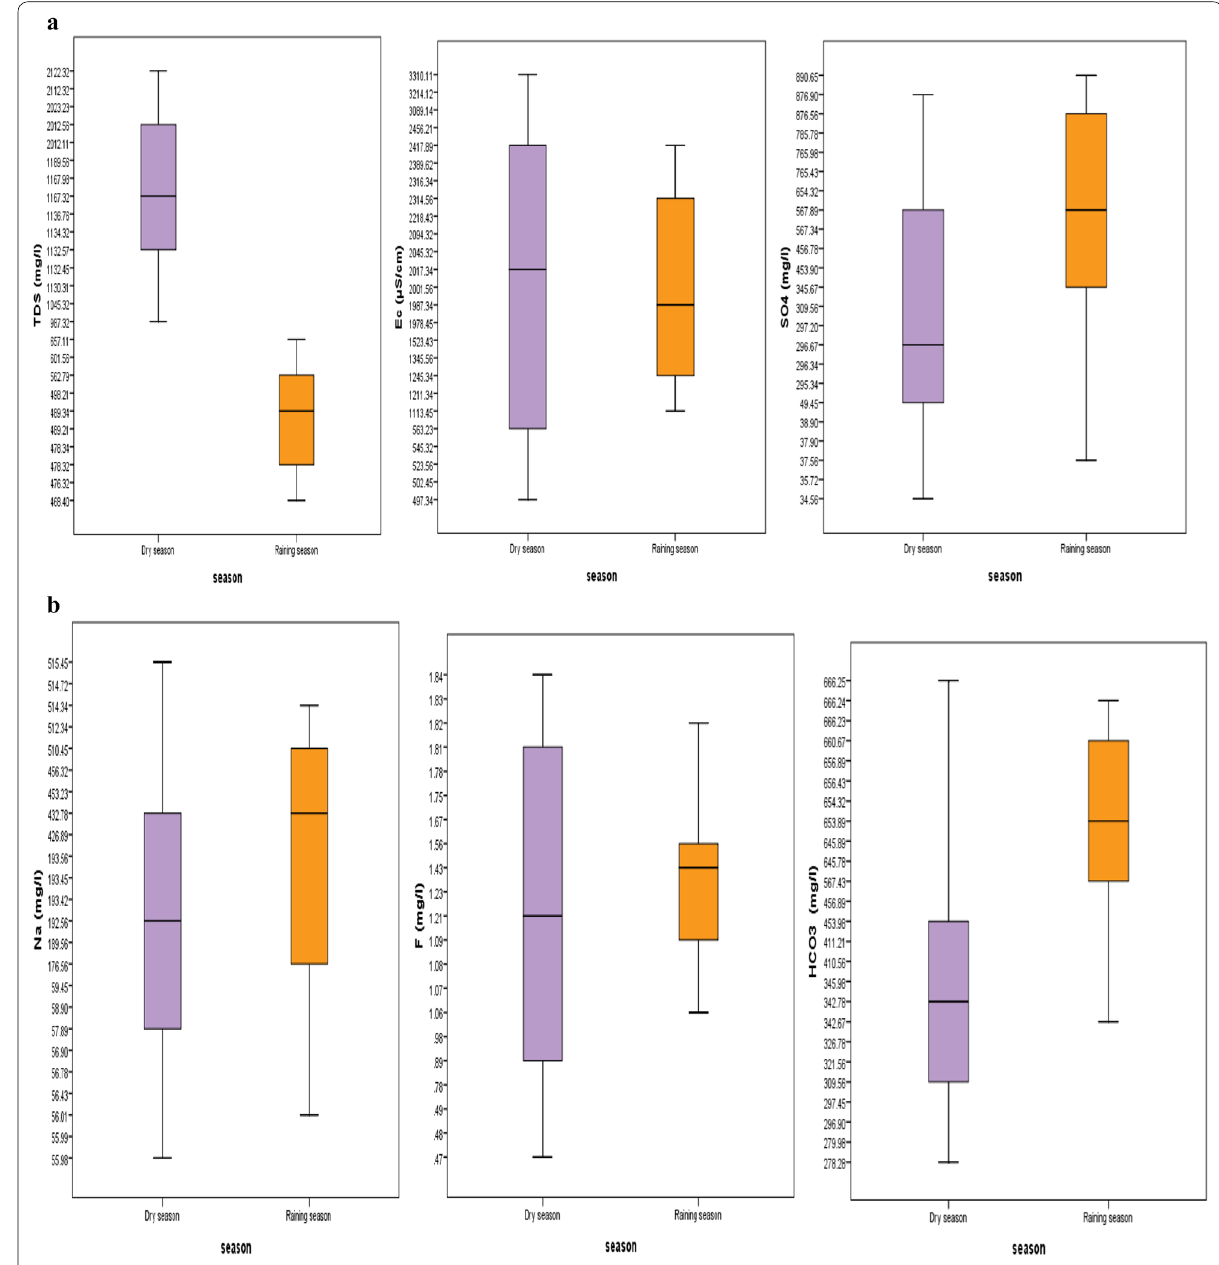
Fig. 3 a Spatial variations of TDS, EC and SO 42 − . b Spatial variations of Na + , F − and HCO 3